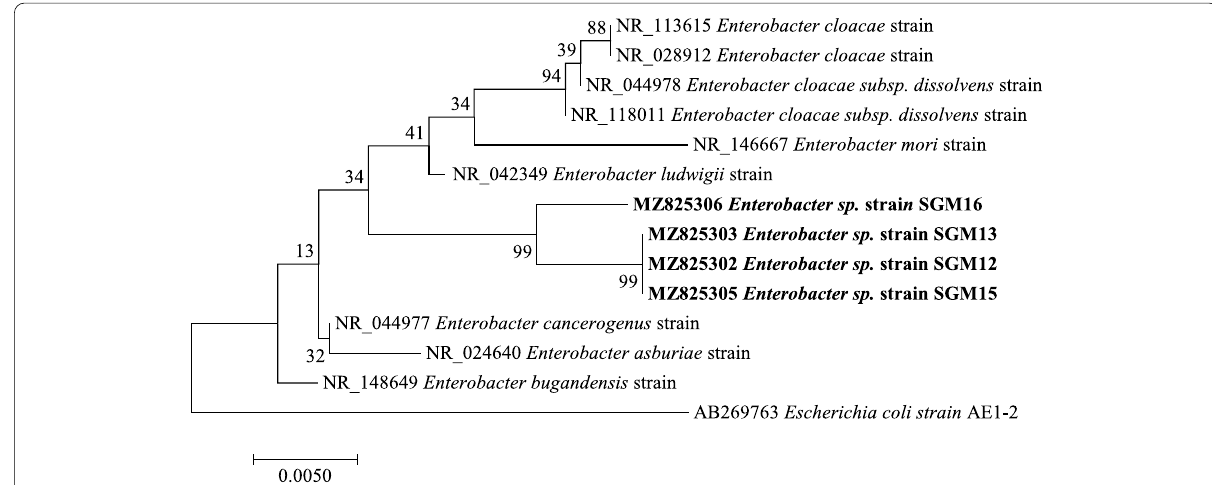
Fig. 4 Maximum likelihood phylogenetic tree based on analysis of partial 16S rRNA nucleotide sequences of Enterobacter sp. strain SGM12, Enterobacter sp. strain SGM13, Enterobacter sp. strain SGM15, and Enterobacter sp. strain SGM16 with reference sequences selected from the NCBI . Escherichia coli strain AE1-2 was used as an outgroup